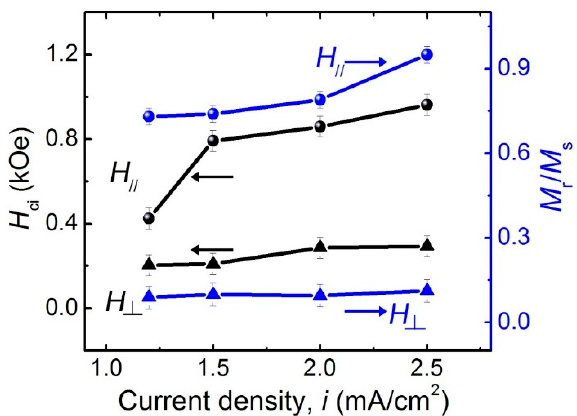
Figure 5. The relationship between coercivity (left, black), squareness (right, blue) of the Ni nanowires and the deposited current densities.